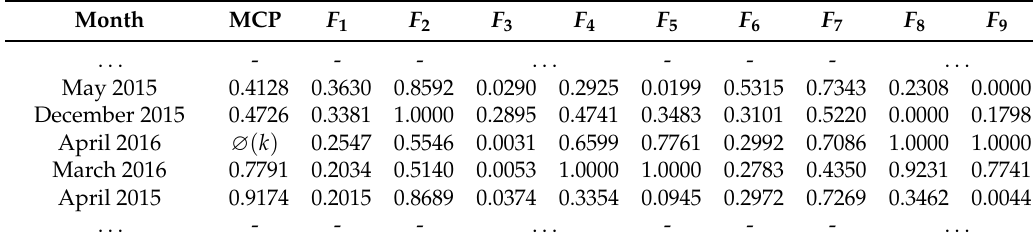
Table 4. Ranked monthly MCP and the influence factors that contain the forecasting